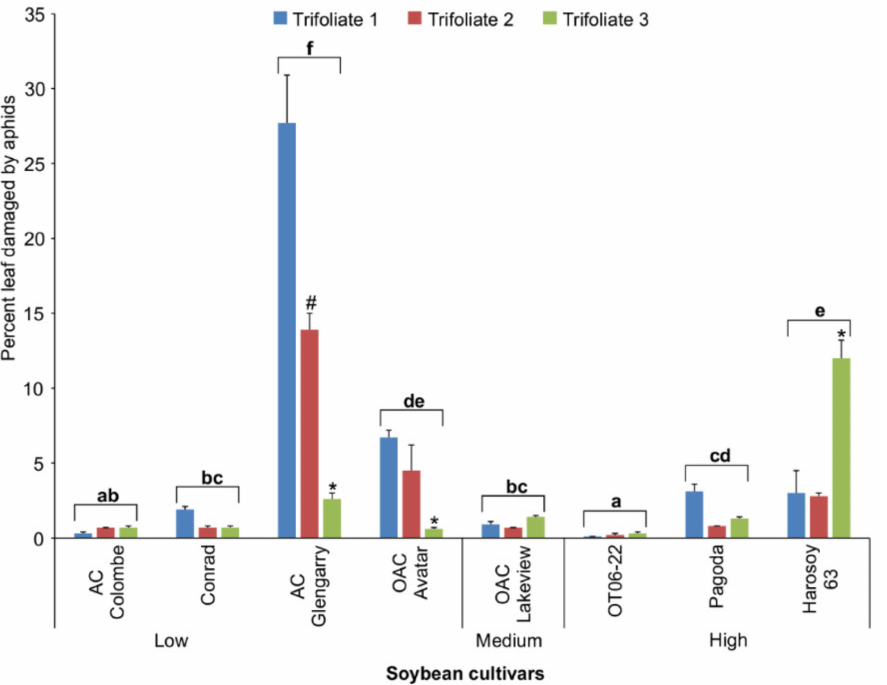
Figure 5. Mean percent damage ( ± S.E.) by soybean aphids to the top 3 trifoliate leaves for 8 soybean cultivars after 4 weeks growth in the greenhouse. Bars with the same lowercase letters indicate no significant difference ( p > 0.05) for mean percent leaf damage between those cultivars. Bars with a hashtag (#) or asterisk (*) indicate a significant difference ( p < 0.05) between the percent damage on the 2nd versus the 1st and 3rd, or the 3rd leaf versus the 1st and 2nd trifoliate leaves, respectively. Table 1. Relative aphid resistance ratings for five Ontario-grown soybean cultivars. Soybean cv. Characteristic Aphid Resistance Rating 1 Maple